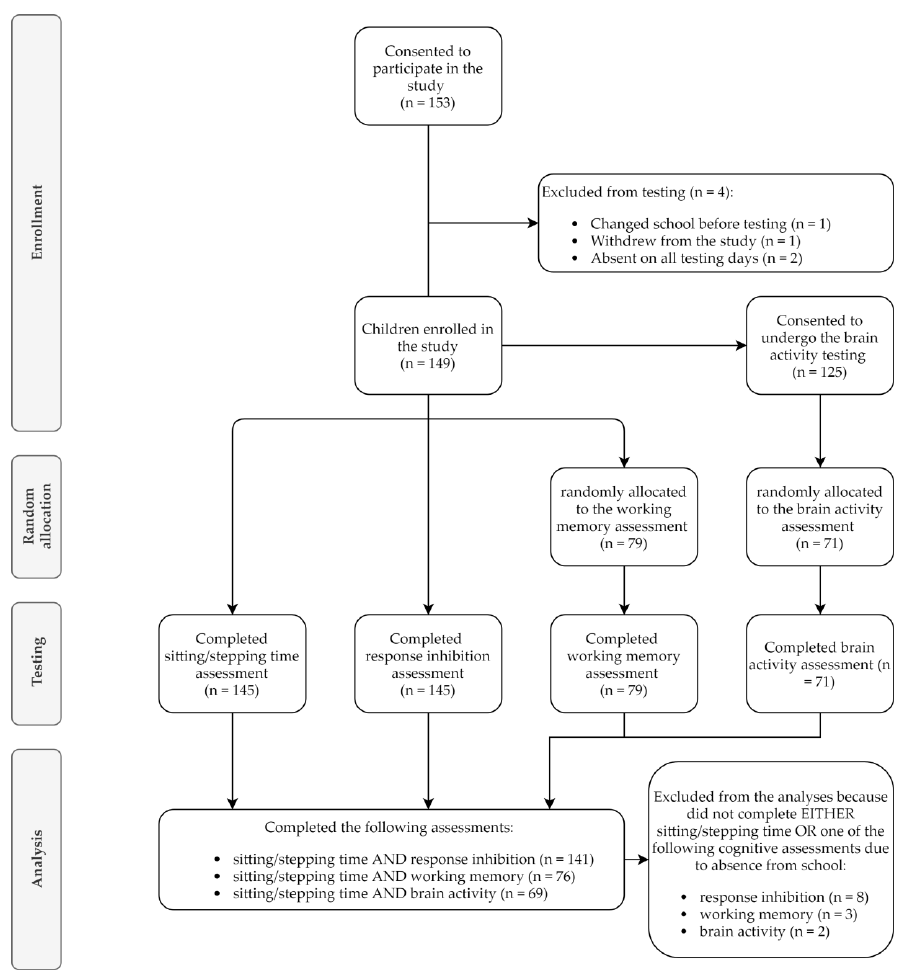
Figure 1. Recruitment according to the Consolidated Standards of Reporting Trials (CONSORT) flow diagram [55].